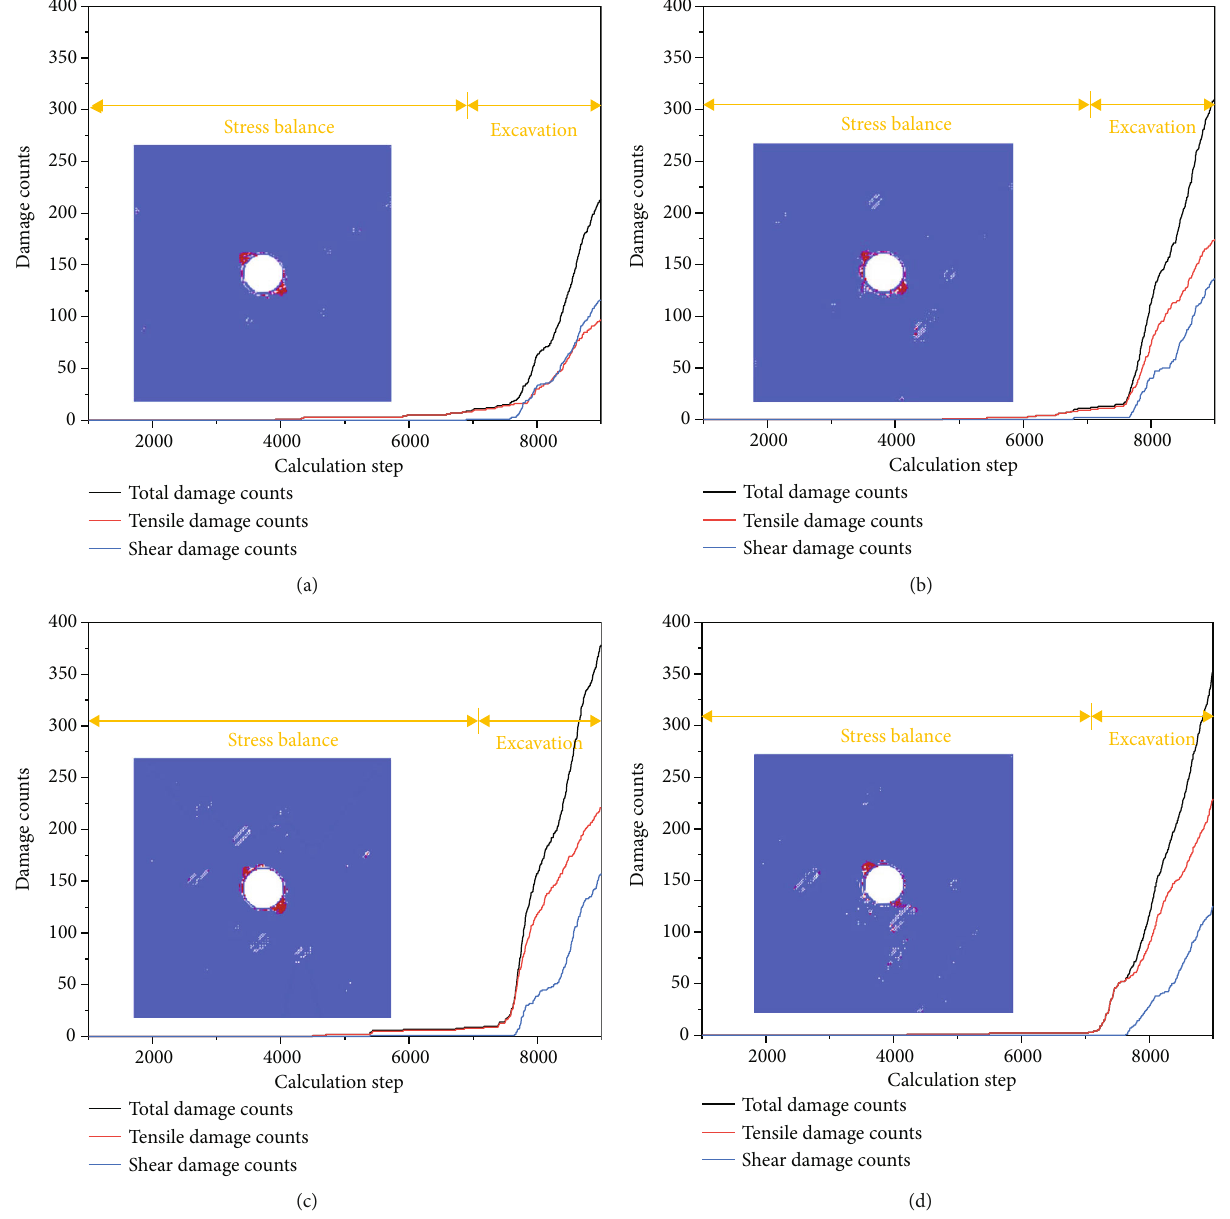
Figure 12: Excavation damage counts under di ff erent fi ssure lengths. (a) fl = 3m . (b) f l = 6m . (c) f l = 9m . (d) fl = 12 m